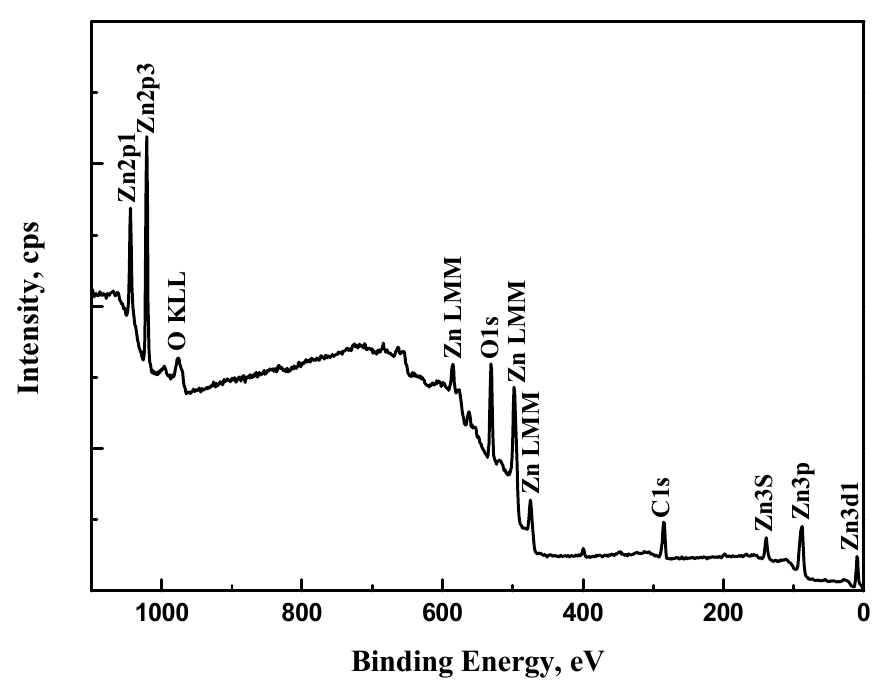
Figure 4. XPS full spectrum of codoped (Al:Fe = 1) film. Table 2. Atomic content of each element in codoped (Al:Fe = 1)